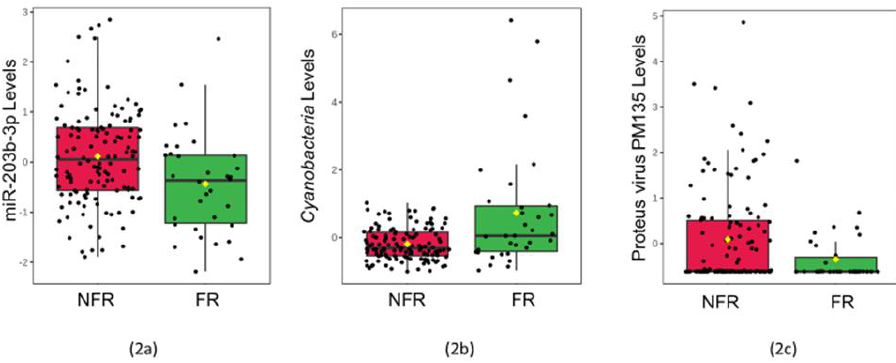
Figure 2. Saliva levels of three multi-omic features differ among infants with food reactions: The box plots display normalized concentrations of one miRNA (miR-203b-3p, adj. p = 0.043, V = 2913) (2 a ), one bacterial phylum (Cyanobacteria, adj. p = 0.048, V = 1515) (2 b ), and one viral species (Proteus virus PM135, adj. p = 0.027, V = 2955) (2 c ) that displayed significant differences (adj. p < 0.05) between 34 infants with food reactions (FR; green) and 130 peers with no food reactions (NFR; red) on Wilcoxon Rank Sum Testing. Normalized, scaled levels of each molecular feature are shown in the box plots, with the mean (black horizontal bar), median (yellow diamond), and standard error